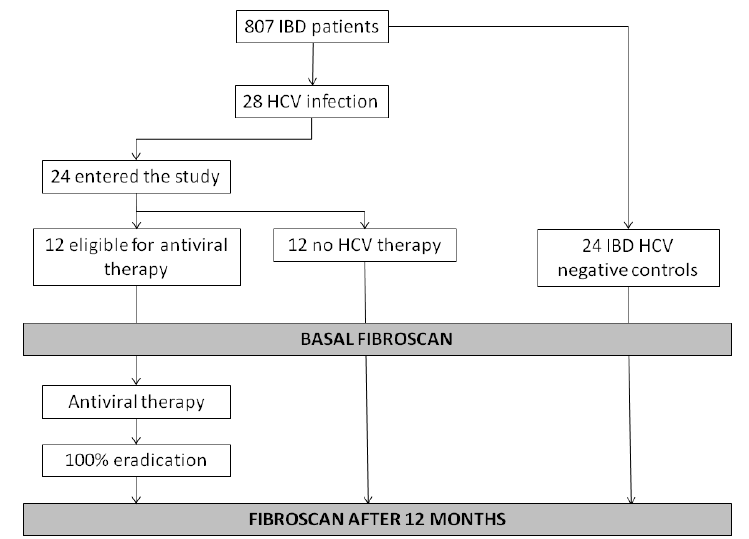
Figure 1. Flowchart reporting patients selection and study protocol. IBD: inflammatory bowel disease; HCV: hepatitis C virus.